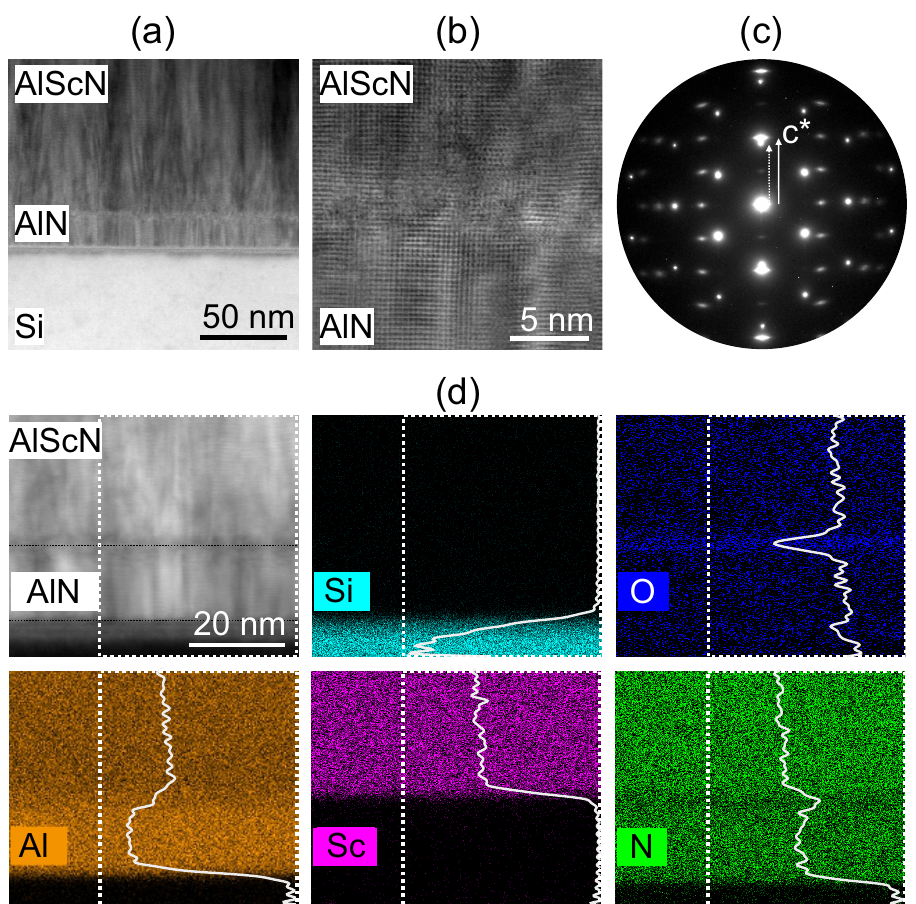
Figure 5. TEM study of the sample Si/AlN/AlScN. ( a ) STEM ABF overview image showing the columnar grain structures of AlN and AlScN layers on a natively passivated Si substrate; ( b ) HRSTEM ABF image showing structural disorder at the AlN/AlScN interface; ( c ) SAED pattern containing reflections of all layers corresponding to the [110] Si, [2¯1¯10] and [1¯100] zone axes of AlN and AlScN; ( d ) STEM EDS elemental maps with integrated intensity profiles over the region of interest (dashed frame). The O-K map demonstrates the formation of an interfacial oxide layer between AlN and AlScN as well as the native oxide on the Si